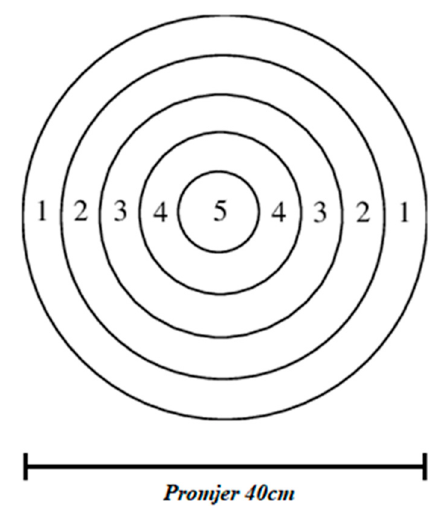
Figure 2. View of the circular target (40 cm in width with points).